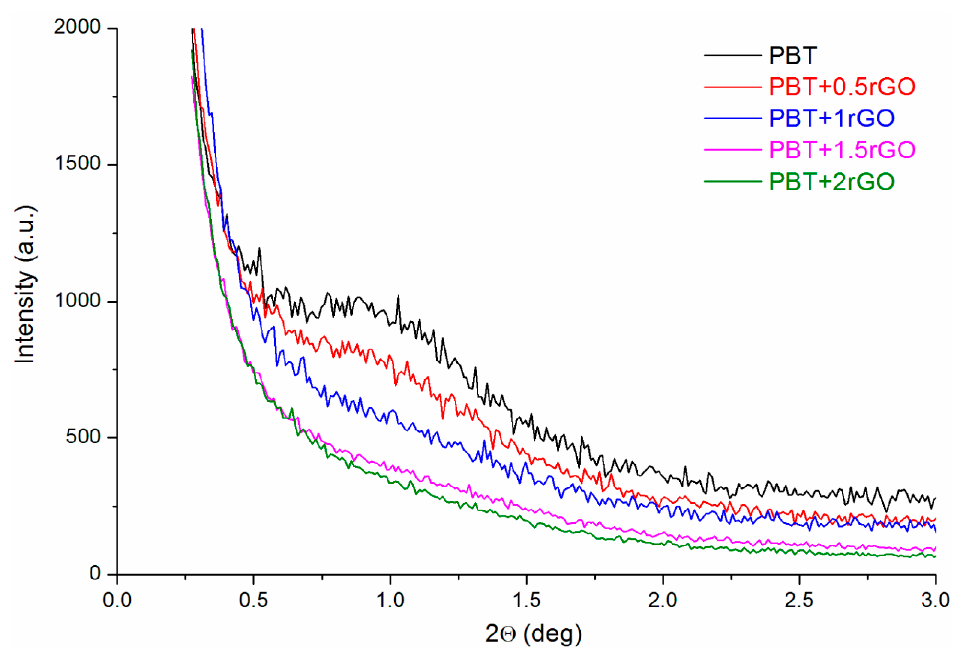
Figure 9. Comparison of the SAXS patterns of fibers with different amounts of rGO content spun at V = 800 m/min.